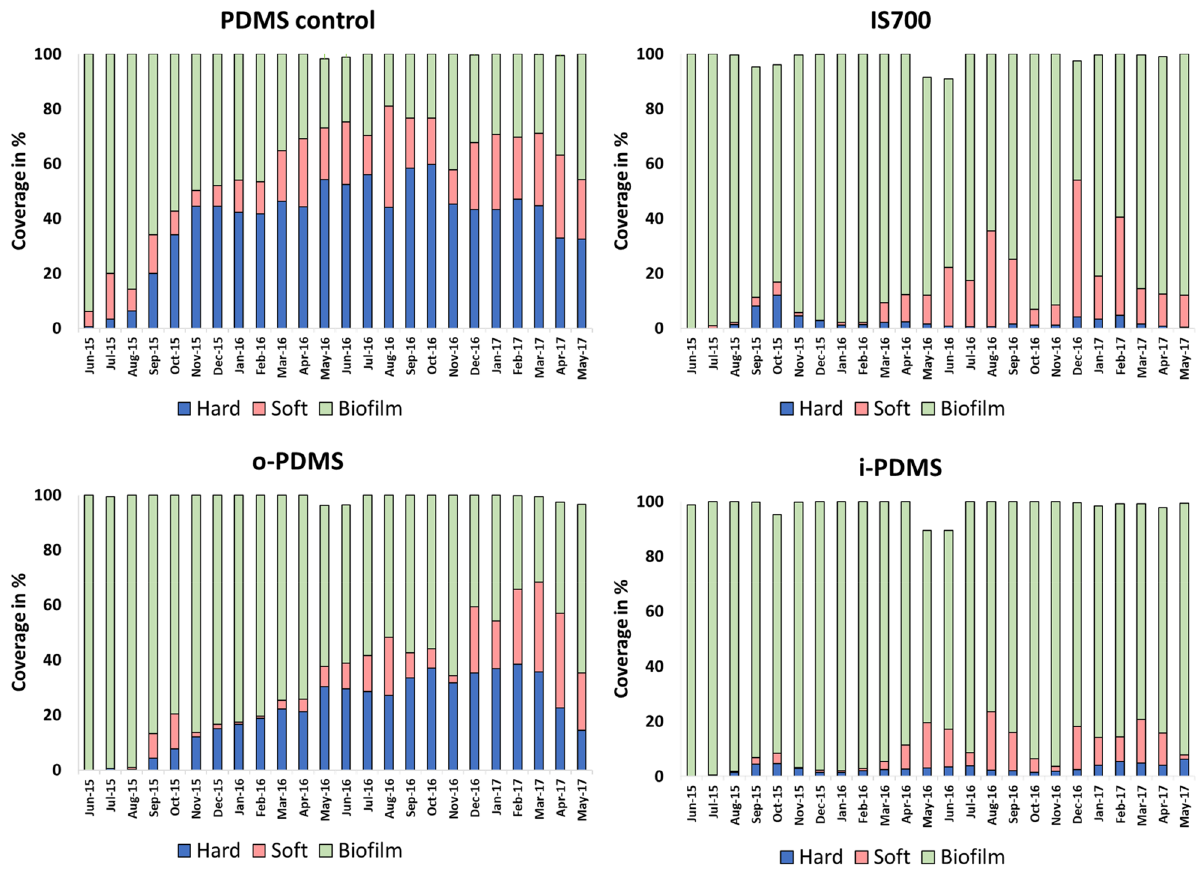
Figure 4. Fouling trends on PDMS, IS700, o-PDMS and i-PDMS in Singapore Harbor in a 24-month immersion period from June 2015 to May 2017. Number of samples (N) =